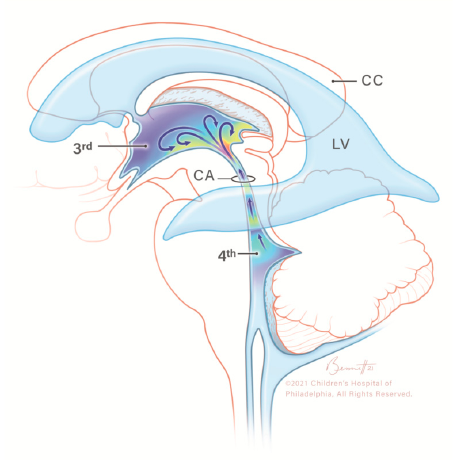
Figure 3. Illustration of caudocranial cerebrospinal fluid (CSF) flow direction, circulating from the fourth ventricle, passing through the cerebral aqueduct into the third ventricle (arrows). CC, corpus callosum; CSF, cerebrospinal fluid; LV, lateral ventricle; 3rd, third ventricle; CA, cerebral aqueduct; 4th, fourth ventricle. Modified from Hwang et al. with permission.